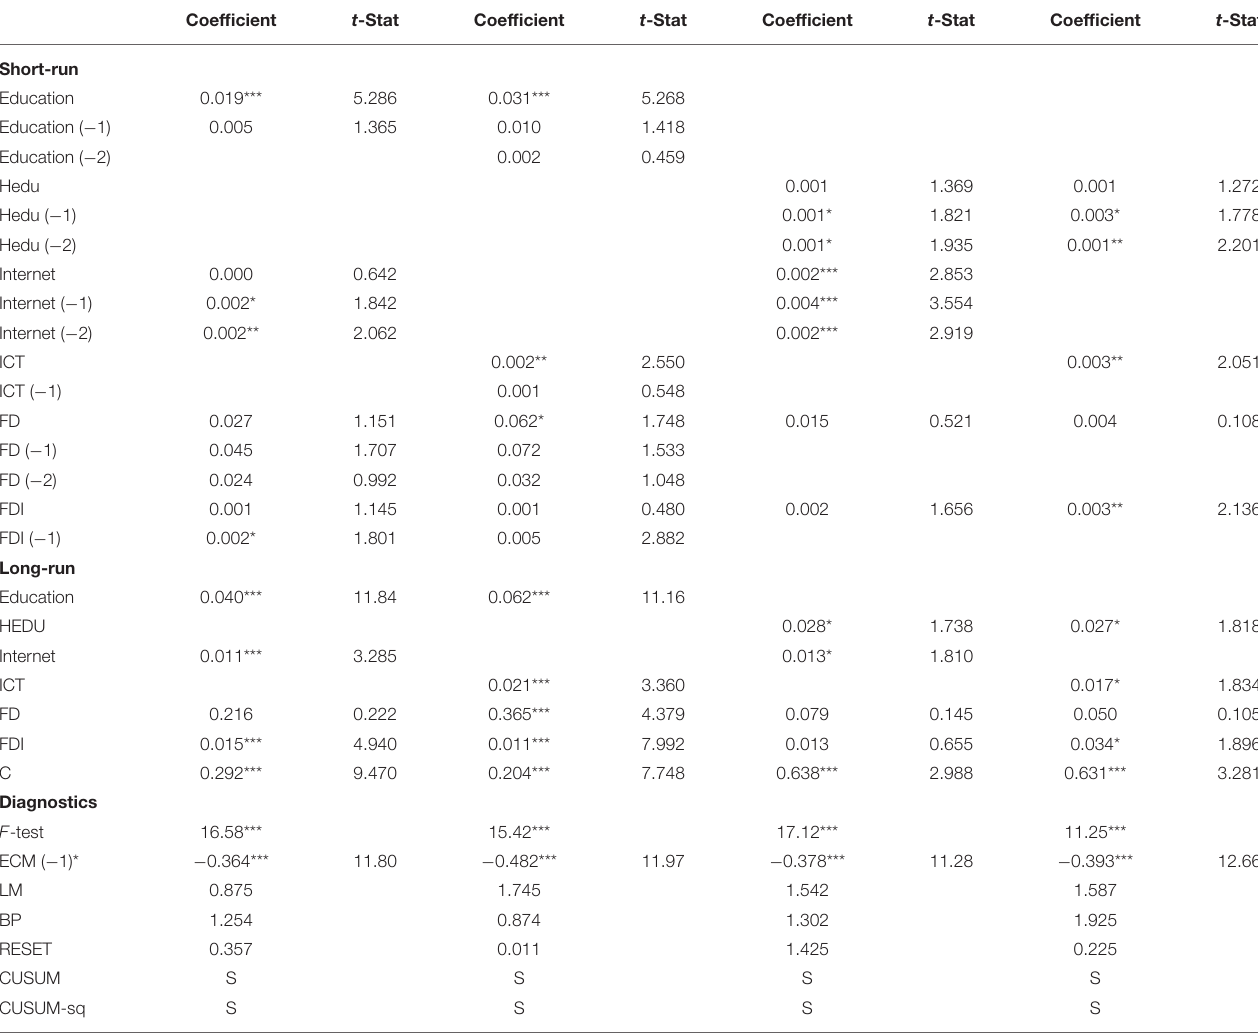
TABLE 3 | ARDL estimates of quality of life. Coefficient t -Stat Coefficient t -Stat Coefficient t -Stat